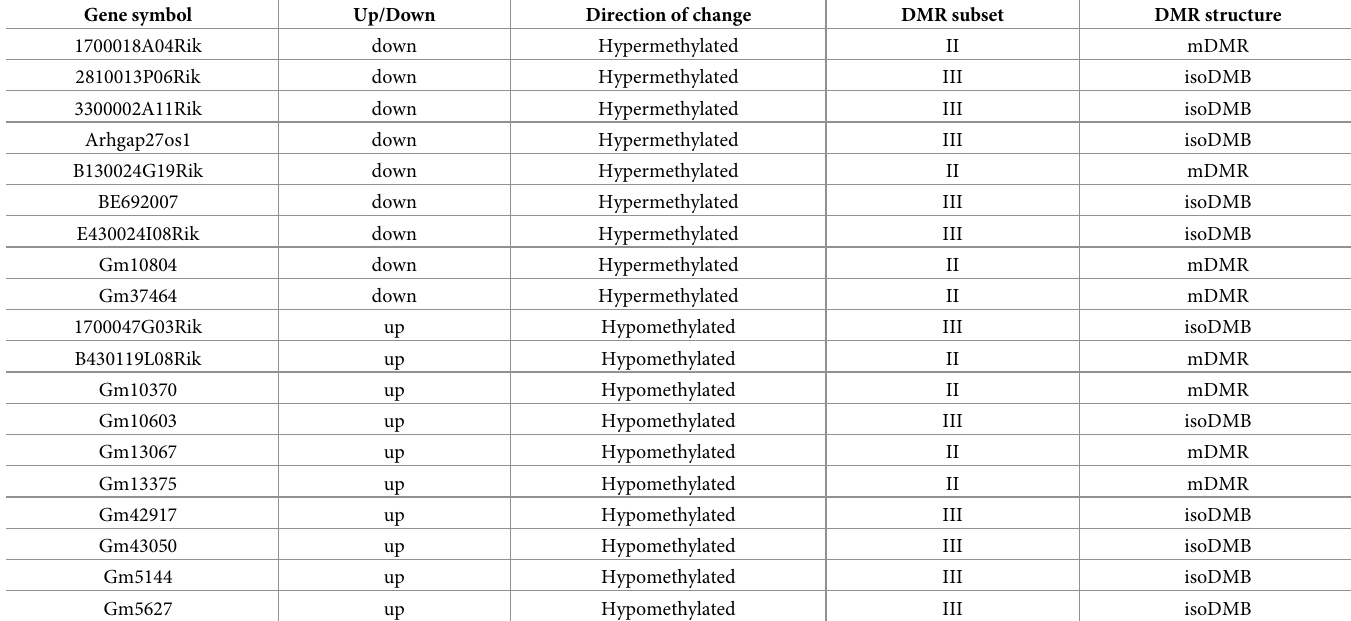
Table 2. LncRNAs associated to genomic structures defined using TBT-dependent DNA methylome. Gene